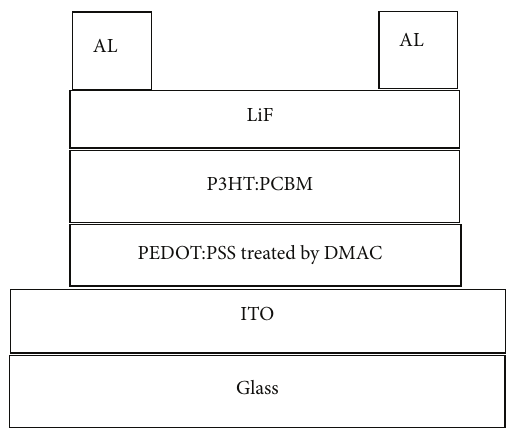
Figure 1: The device structure of the solar cells, P3HT:PCBM as the active layer and the PEDOT:PSS modified by the